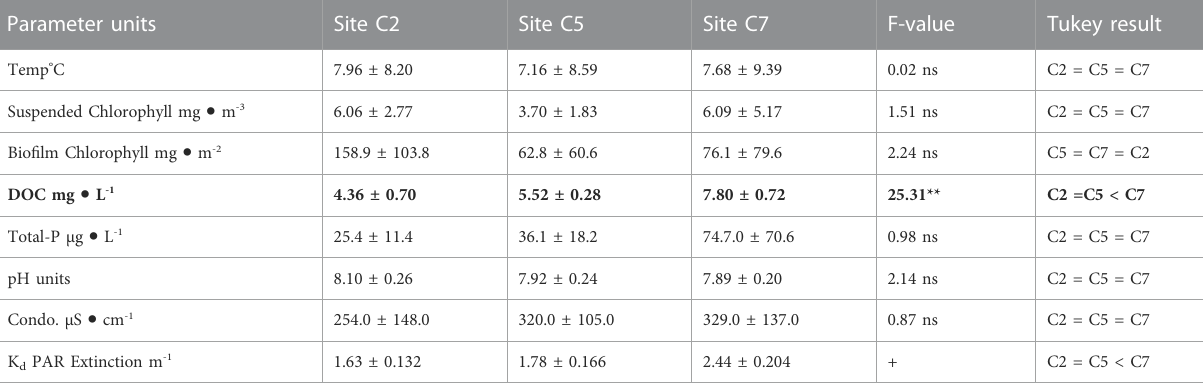
TABLE2Average (±onestandard deviation)biogeochemical conditions compared amongthreestream sitesinthe ChippewaRiver watershed whereexperiments were carried out. Measurementswere made atapproximately monthly intervals; naturally occurring bio fi lmswere sampled from two stream rocks, while all other water chemistry measurements were made from single grab samples collected from the overlying water column (December 2012 – 13). Comparisons were made using one-way MANOVA coupled with Tukey ’ s HSD pairwise mean tests (where ns = not signi fi cant, ** p < 0.001). + For light extinction, Tukey ’ s comparisons were done on pairwise differences between the extinction coef fi cients. F values in bold were statistically signi fi cant.